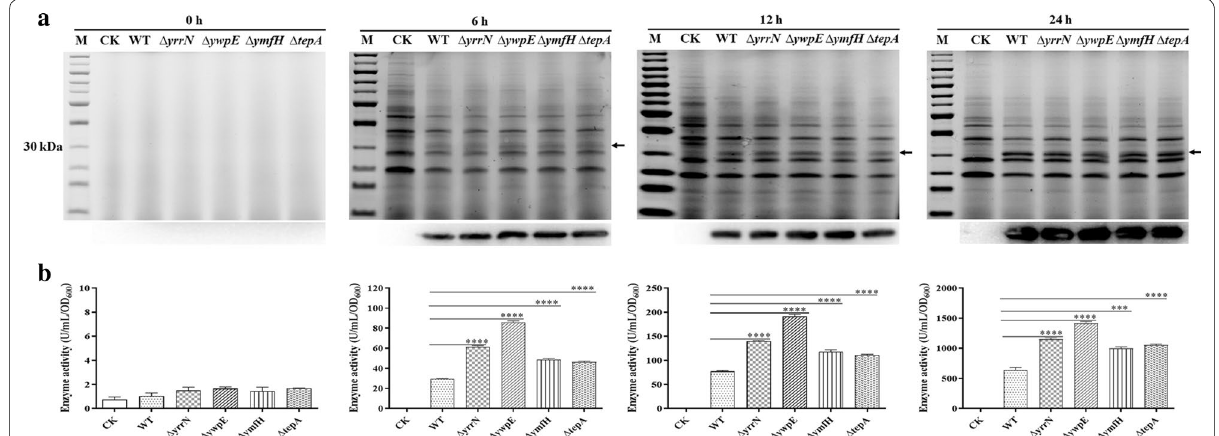
Fig. 4 Secretion of AiiO‑AIO6 by intracellular protease‑deficient strains. a SDS‑PAGE (up) and Western blotting (down) of AiiO‑AIO6 secreted in culture medium derived from wild‑type (WT) strain 1A751 or intracellular protease‑deficient mutants after different time points cultivation at 37 °C. M, protein marker; CK, pWB980/BS1A751, wild‑type (WT), pWB980‑AIO6BS/BS1A751; ∆ ymfH , ∆ yrrN , ∆ ywpE , ∆ tepA : intracellular protease‑deficient mutants harboring the expression vector pWB980‑AIO6BS. b Secreted AiiO‑AIO6 activity present in wild‑type or intracellular protease‑deficient mutant culture medium. p values were calculated using unpaired two‑tailed T‑tests. An asterisk indicates a statistically significant difference between two activity values ( p <